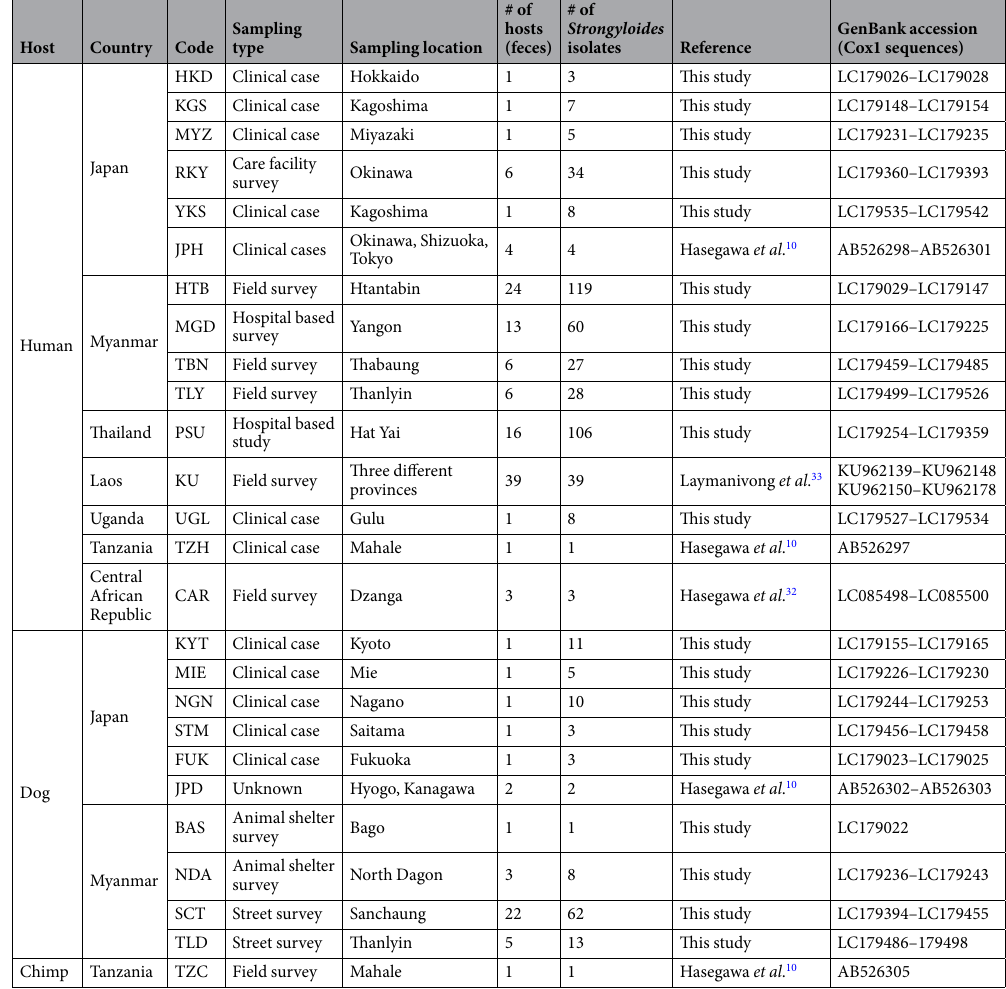
Table 8. Summary of Strongyloides isolates used in this study. Multiple nematodes were collected from a single fecal specimen. Both the number of hosts and number of nematodes isolated are shown. In the case of Myanmar dogs, for the calculation of host animal numbers, we assumed that each fresh fecal sample found on the streets or floors of animal shelters belonged to different dogs. We also included Cox1 sequence data available from the NCBI Nucleotide